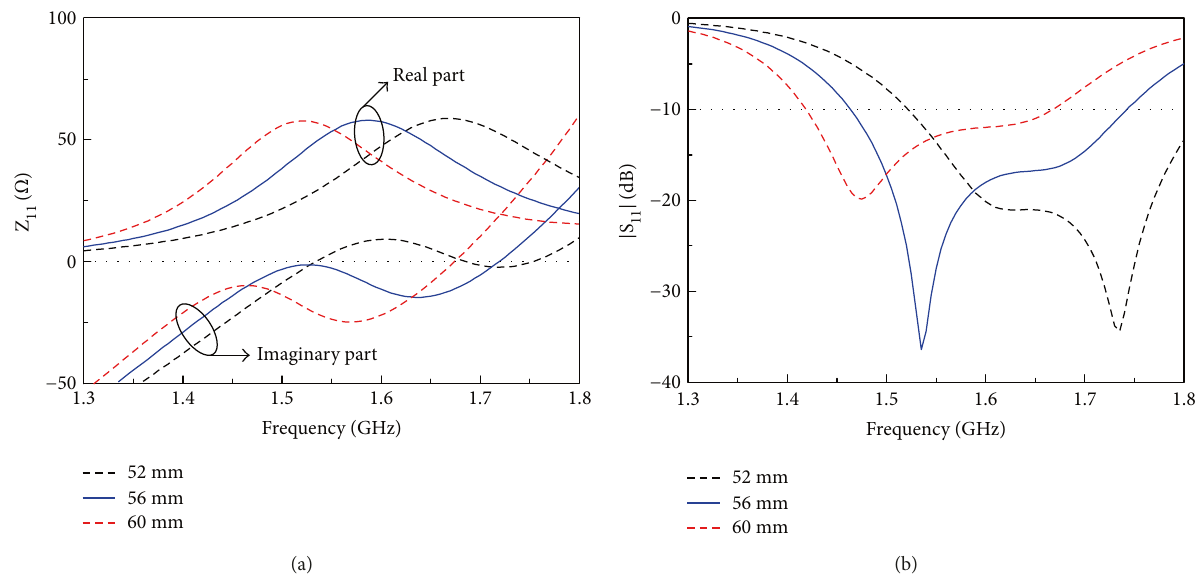
Figure 5: Simulated (a) input impedance and (b) |S the parasitic patch ( R ). p